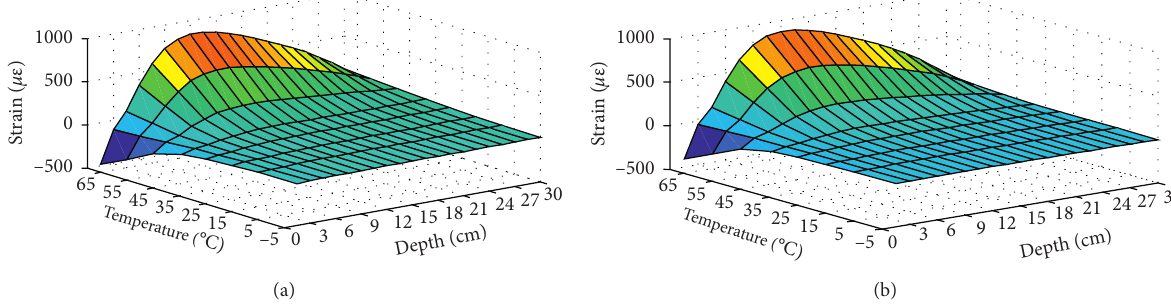
Figure 15: The distributions of strains within asphalt layers of (a) flexible pavement and (b) semirigid pavement under FWD loading.